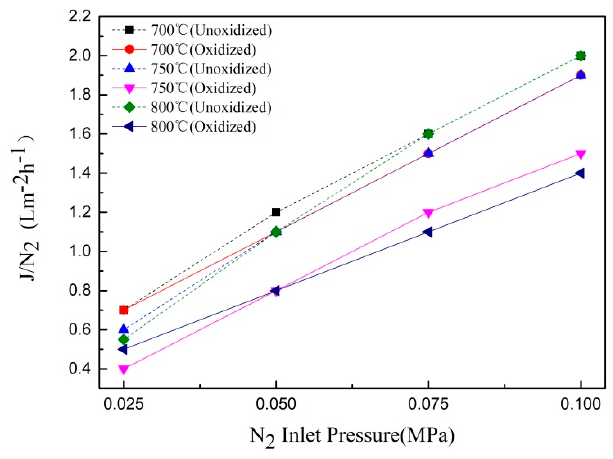
Figure 9. Gas flux curve of the Ti support after 60 min of oxidation at different temperatures.